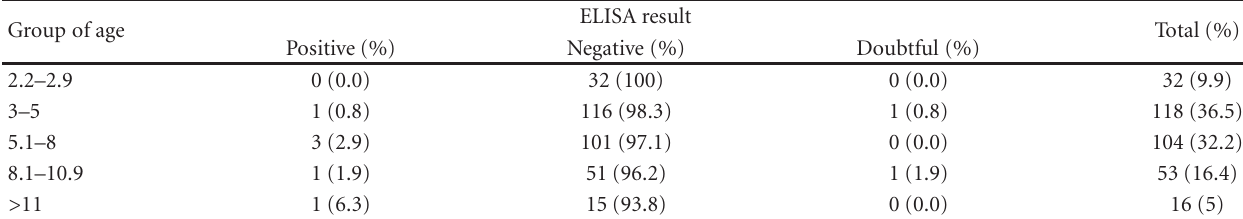
Table 4: ELISA results according to group of age of 323 animals from five dairy herds. Group of age